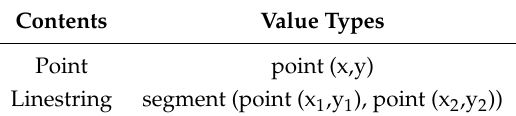
Table 3. R-tree for point and linestring objects.